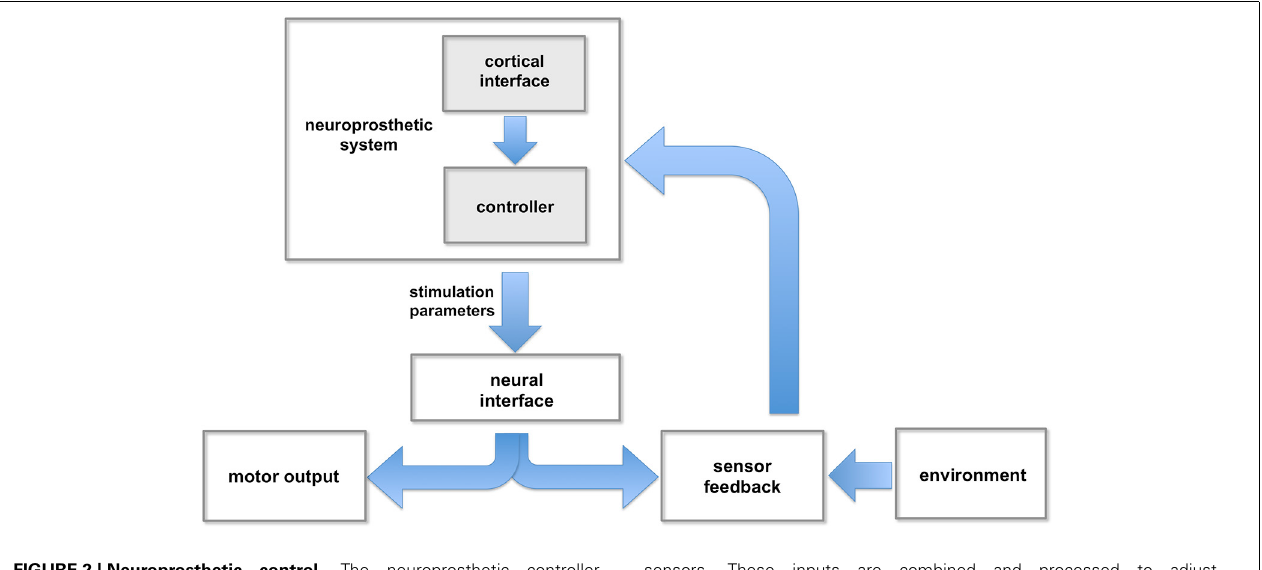
FIGURE 2 | Neuroprosthetic control. The neuroprosthetic controller receives user commands (e.g., intended movement) extracted from cortical signals, and feedback information from different